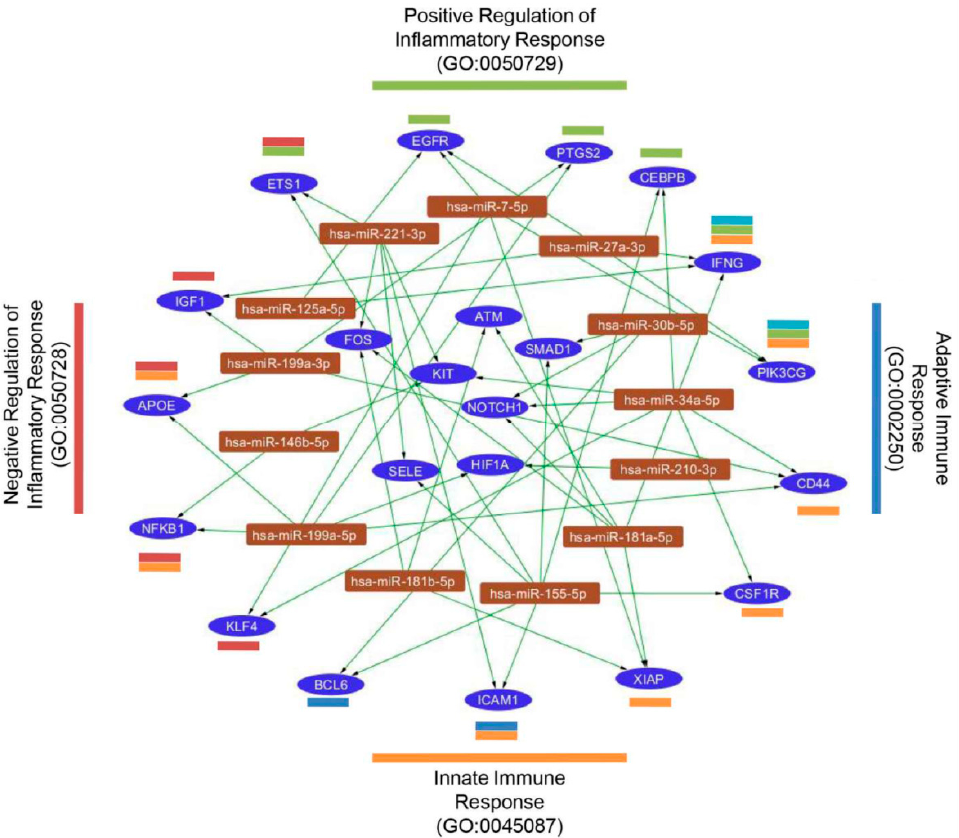
Figure 5. Predicted target genes for miRNAs. Target genes for significantly increased miRNAs on primed MenSC secretomes were analyzed by miRTargetLink. Target genes were first classified into the category Inflammatory Response (GO:0006954) and then subclassified into four subcategories (Innate Immune Response (orange), Adaptive Immune Response (blue), Positive Regulation of Inflammatory Response (green), and Negative Regulation of Inflammatory Response (red)). The interaction network of gene targets (blue ellipses) and miRNAs (brown rectangles) was illustrated using Cytoscape.